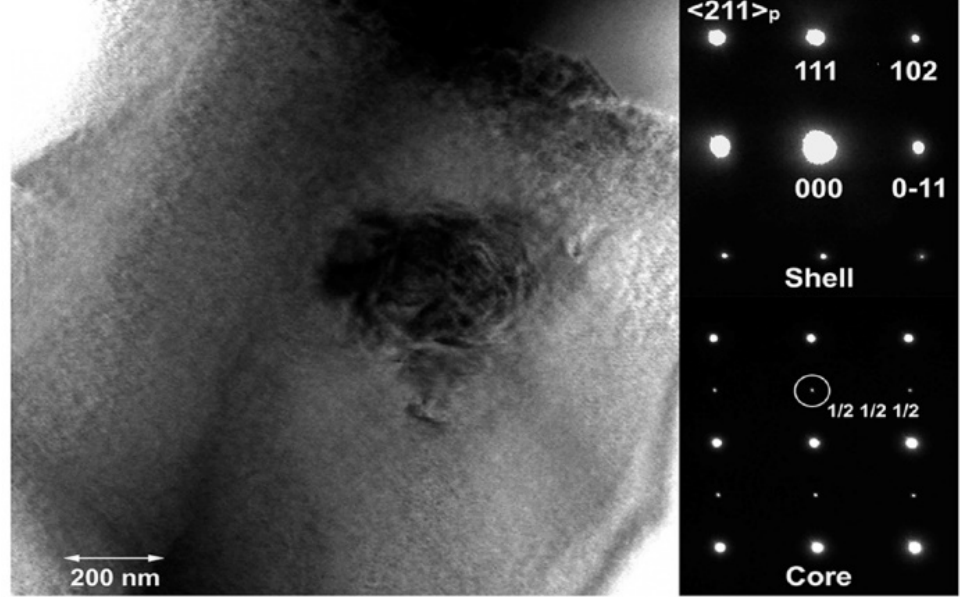
Figure 9. Bright field TEM image of 0.05Bi(Zn 2/3 Nb 1/3 )O 3 -doped BF–BT, and diffraction pattern in core and shell regions. Reprinted with the permission of [78]. Copyright © 2018 American Chemical Society.